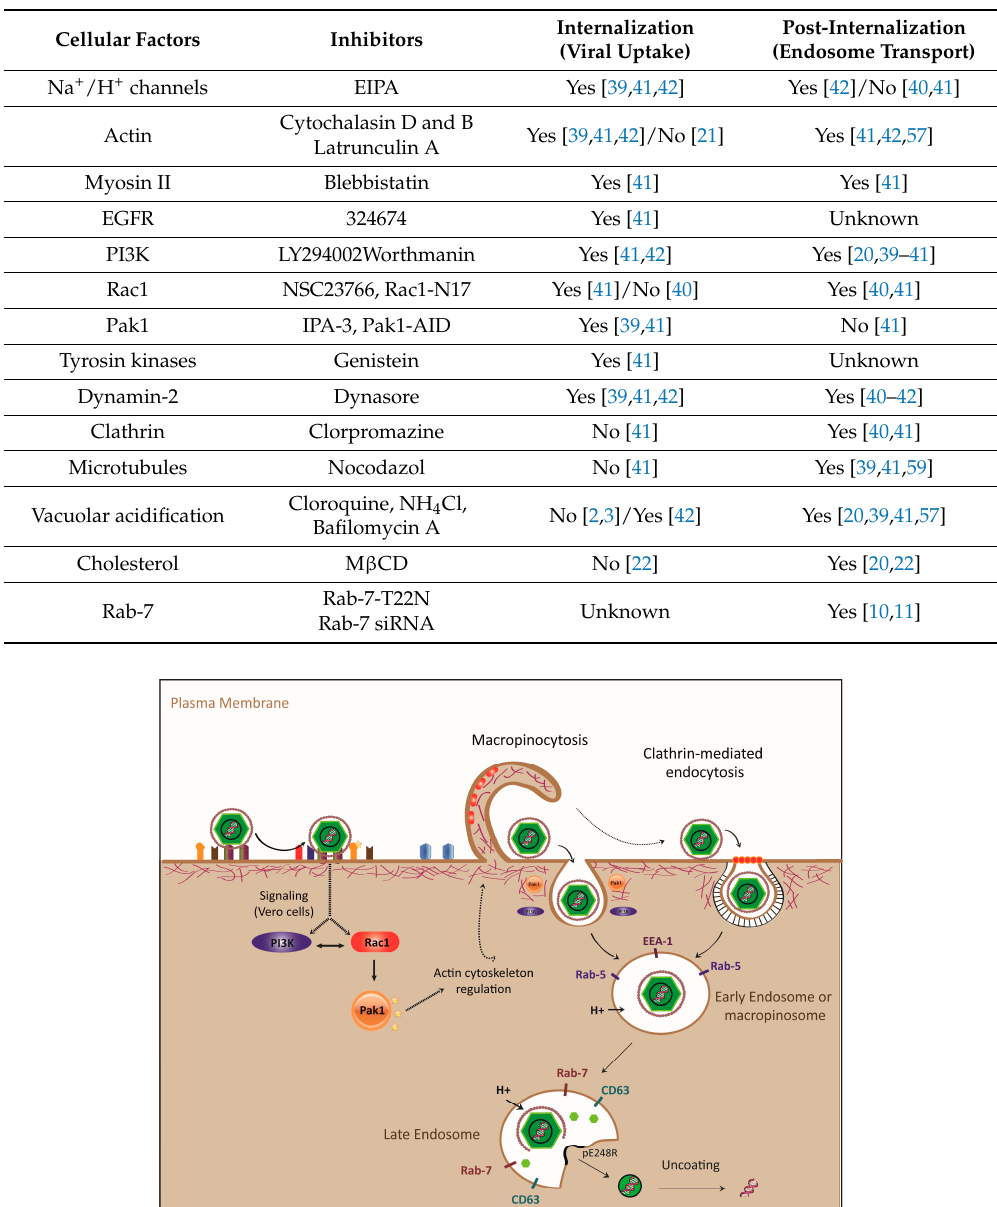
Table 1. Cellular factors involved in ASFV entry. The table shows the cellular factors that play an important role during internalization through the plasma membrane (viral uptake) and/or post-internalization steps (endosome transport) according to published data. The type of inhibitor or dominant negative construct used for analysis is also shown.